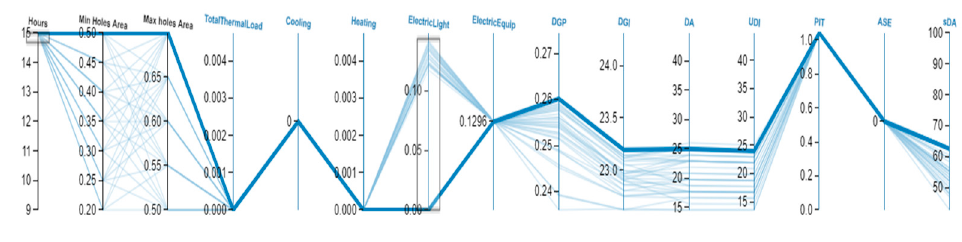
Figure 23. Choosing the optimal conditions for different hours on 20th March. Table 7. Best values for the opening ratio of shading device on 20th March.